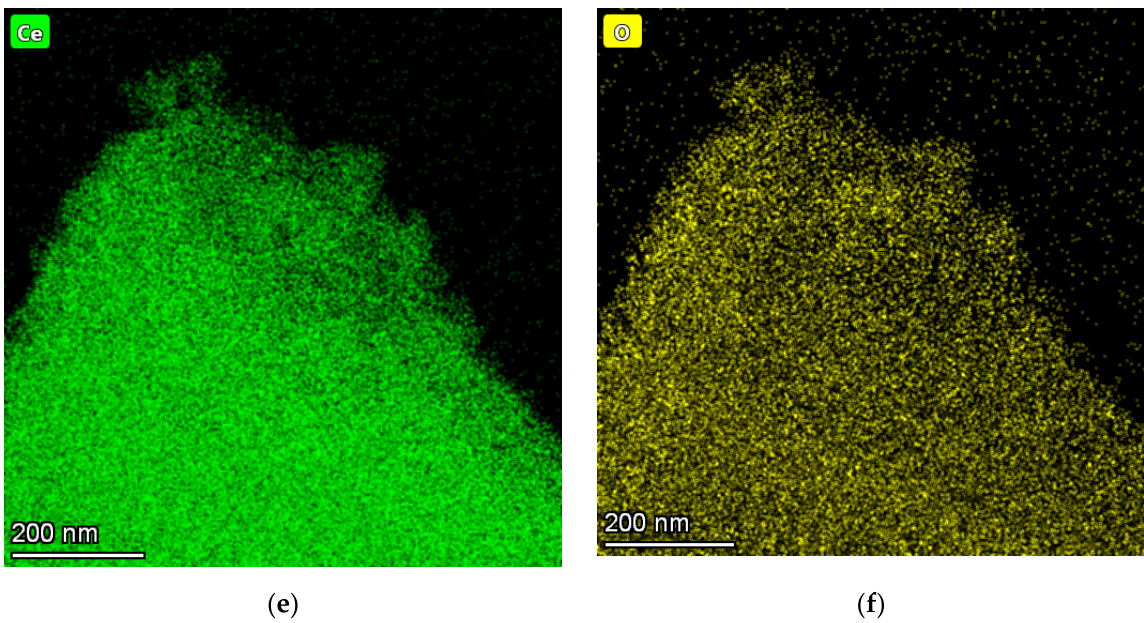
Figure 3. ( a ) TEM and ( b ) HRTEM images of CeO 2 -Na-NiO, with the inset in ( b ) giving the fast Fourier transform of corresponding HRTEM; ( c ) HAADF-TEM image and corresponding EDS maps of CeO 2 -Na-NiO for ( d ) Ni, ( e ) Ce, and ( f ) O.